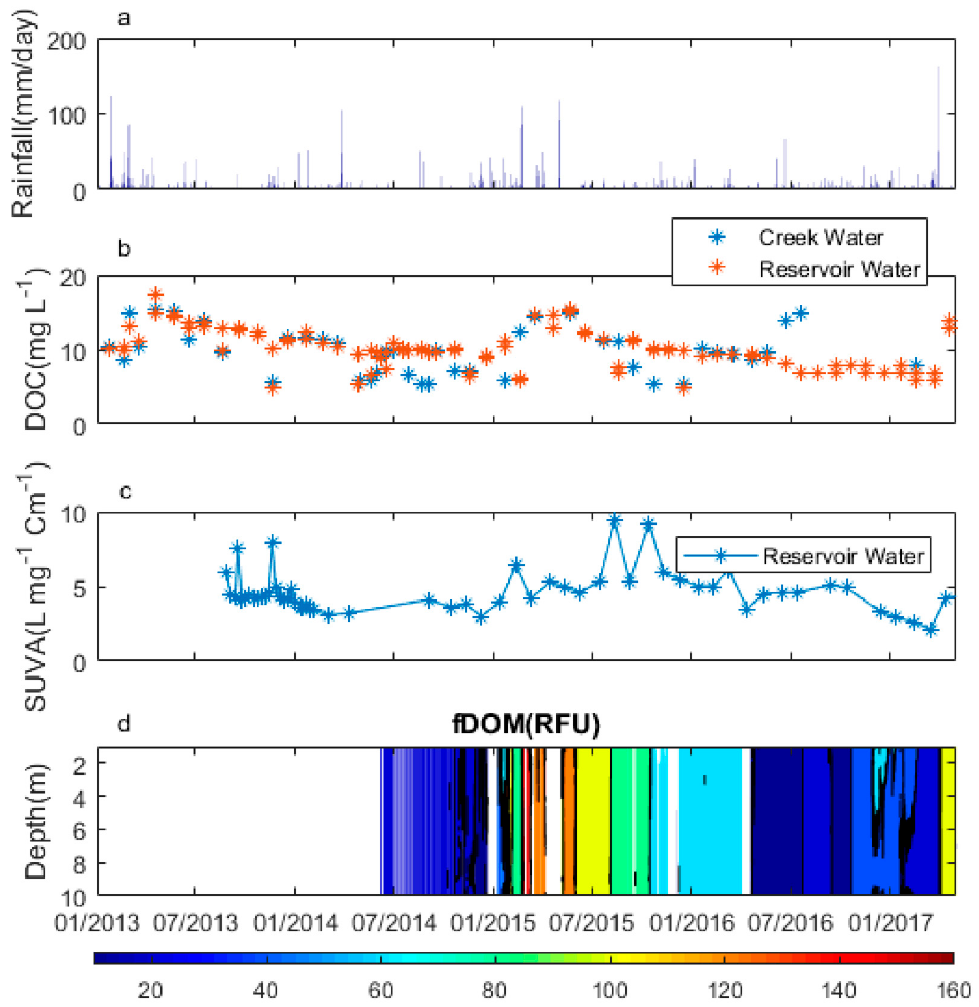
Figure 5. Time series of ( a ) daily precipitation, ( b ) monthly DOC concentration in creek water and reservoir water (station b), ( c ) monthly SUVA in reservoir water and ( d ) hourly fDOM concentration (unit: RFU), 2013–2017 for Tingalpa Reservoir.